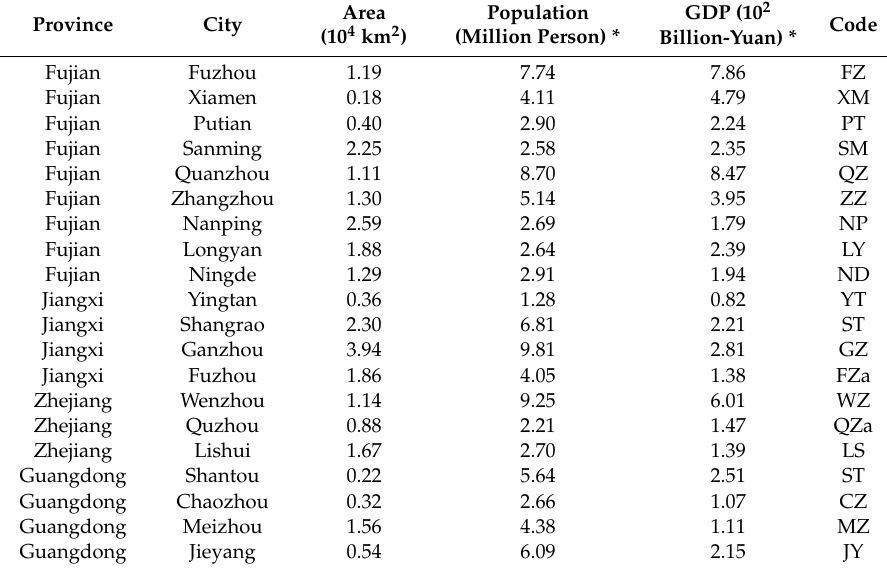
Table 1. Basic information description of each city in WTSUA.